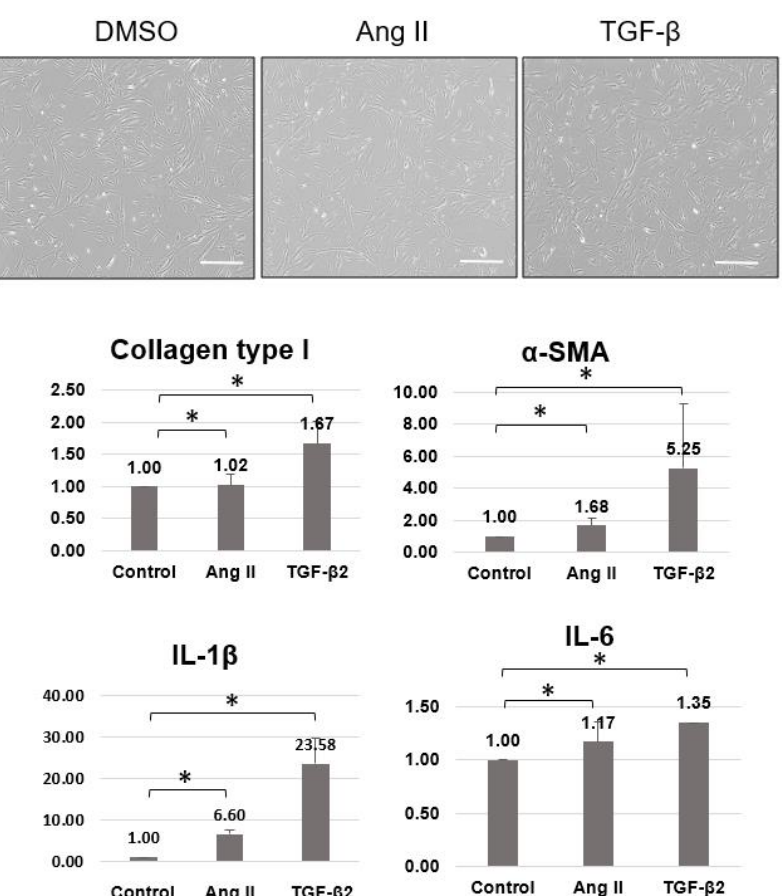
Figure 3. Quantitative PCR of collagen type I, α SMA, and inflammatory cytokines (IL-1 β and IL-6) after AngII/TGF- β application to scleral fibroblasts. Compared to controls, collagen type I, α SMA, IL-1 β , and IL-6 were significantly increased after AngII and TGF- β application to scleral fibroblasts. For quantitative PCR analysis, n = 3 for each group; total n = 9. Scale bar = 500 µ m. The bar represents mean ± SD. * p < 0.05 compared to the